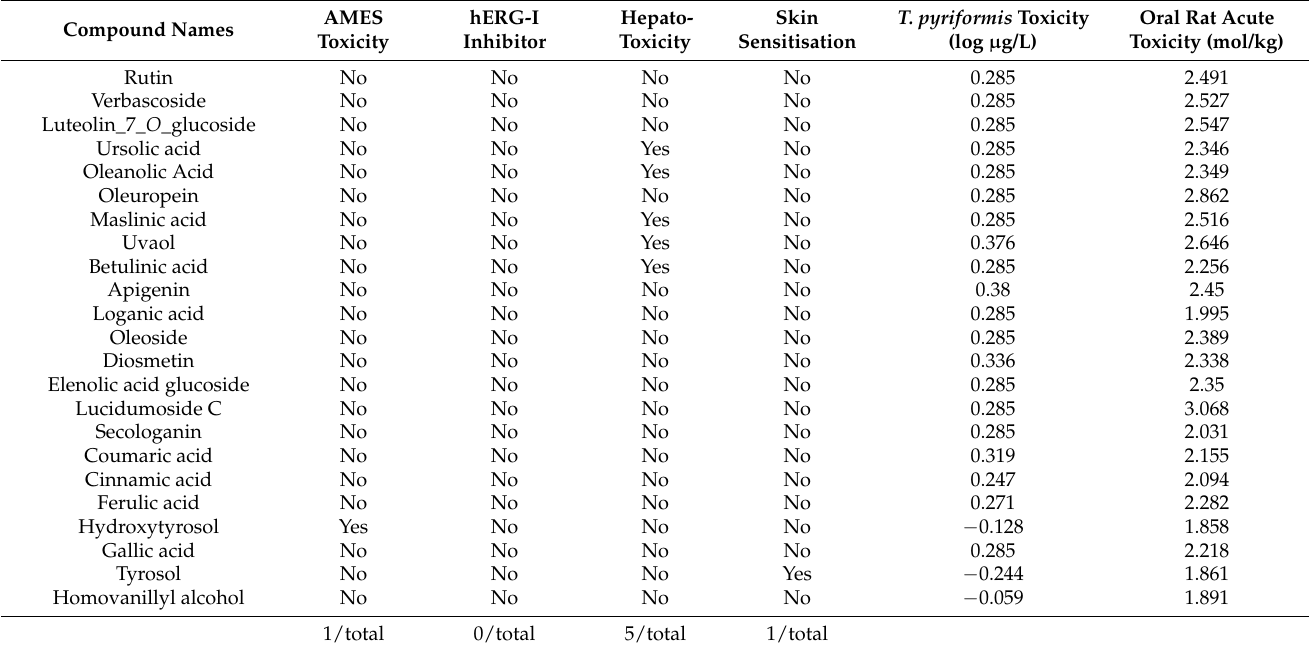
Table 2. Assessment of the toxicity of different bioactive compounds of olive leaf extract (OLE) using pkCSM webserver.